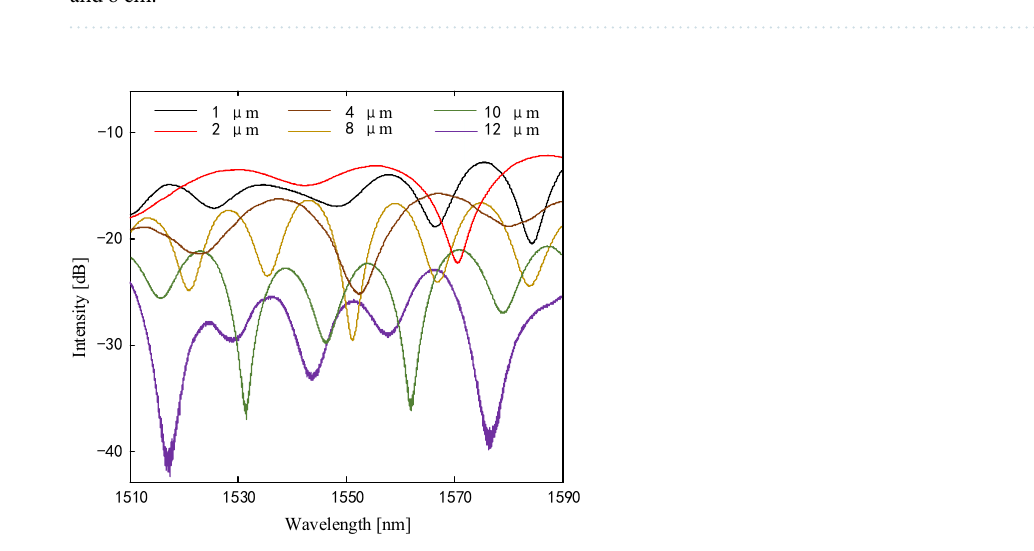
Figure 2. Interference spectra of the four MI samples with core offset of 6 μm and different lengths of 1, 2, 4, and 8 cm.